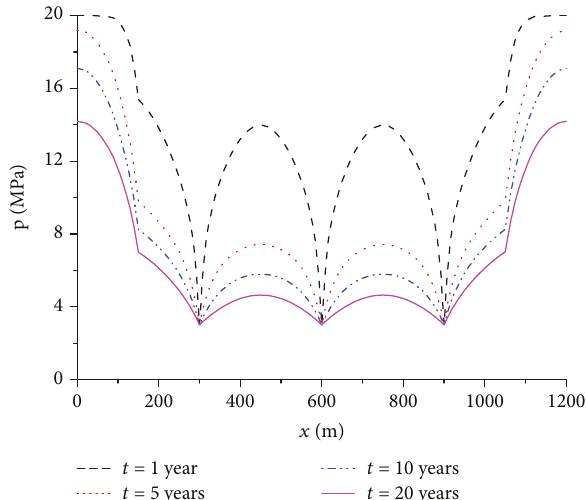
Figure 9: Pressure distribution pro fi le in the thermal-stimulated shale